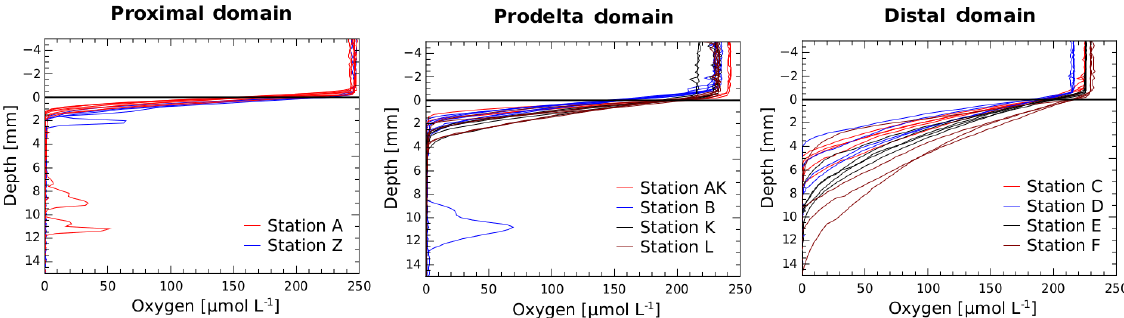
Figure 2. All in situ oxygen micro profiles measured during the DICASE cruise, in the proximal, prodelta and distal domains. The sediment– water interface is marked by a horizontal line (depth = 0).